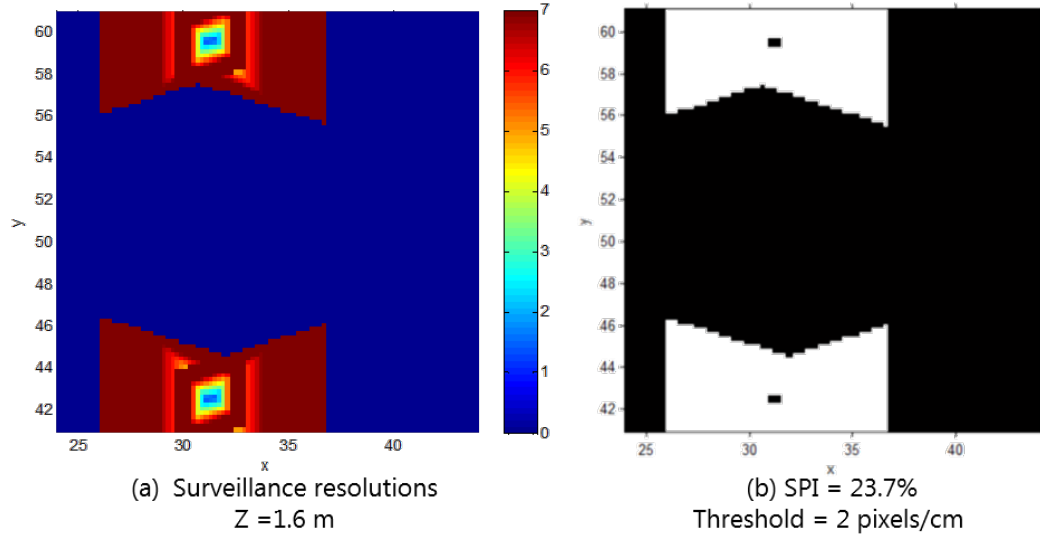
Figure 10. ( a ) Surveillance resolutions when objects are at a 1.6 m height and their orientation is in the direction in which the maximum resolution is achieved; ( b ) Surveillance coverage index with the threshold of 2 px/cm.